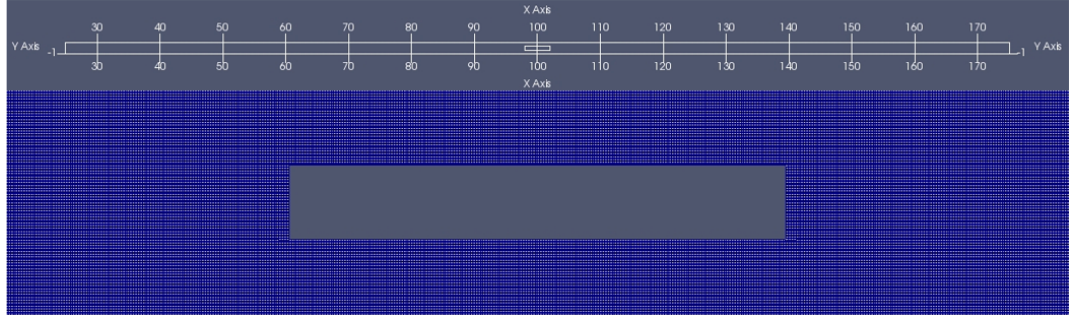
Figure 4. General mesh assembly for solitary wave scattering by a pontoon-coupled model with OW3D run.